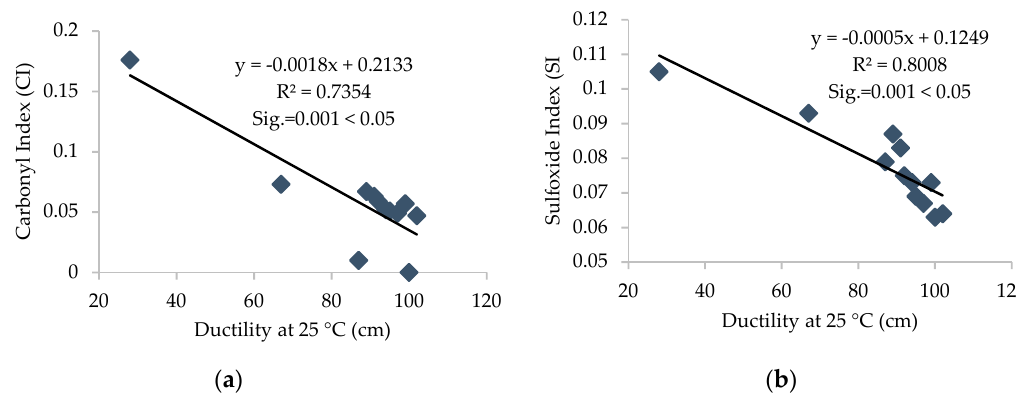
Figure 12. ( a ) Correlation between FTIR indices and ( b ) ductility values of all samples of binders.